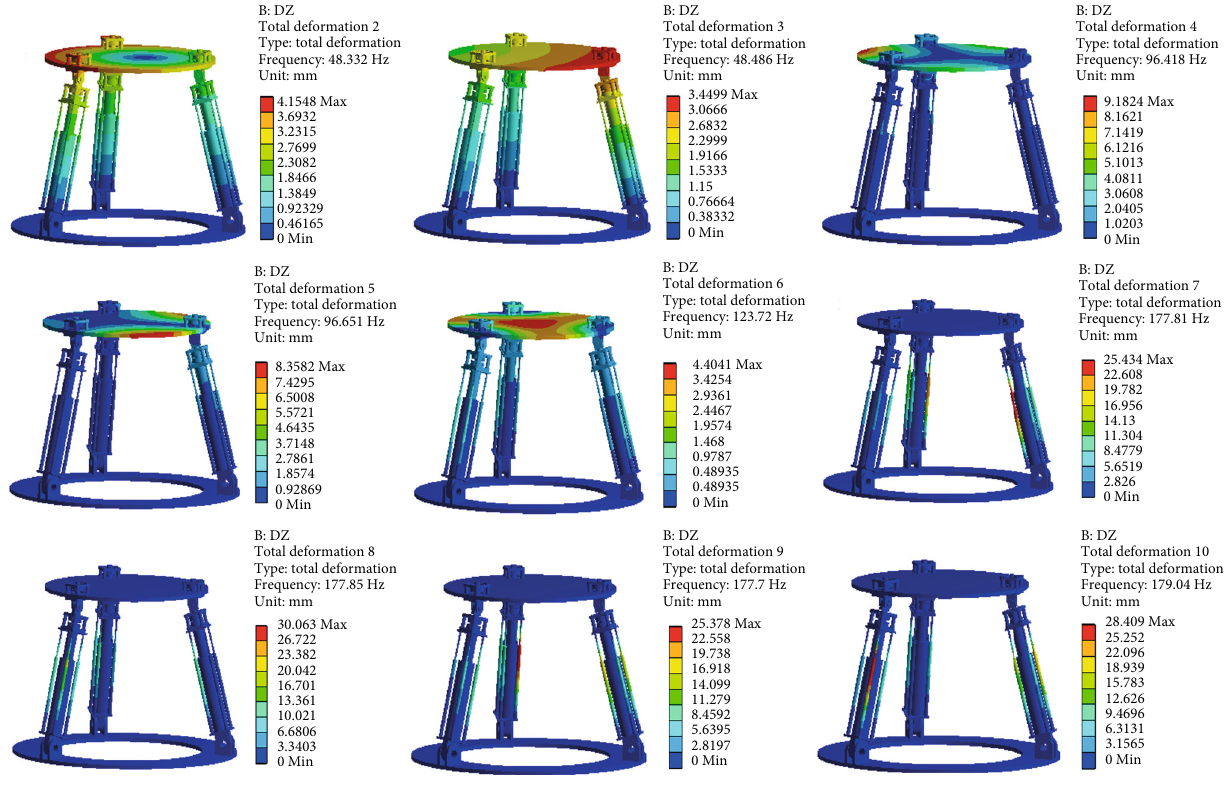
Figure 21: Vibration cloud fi gures of adjusting platform.